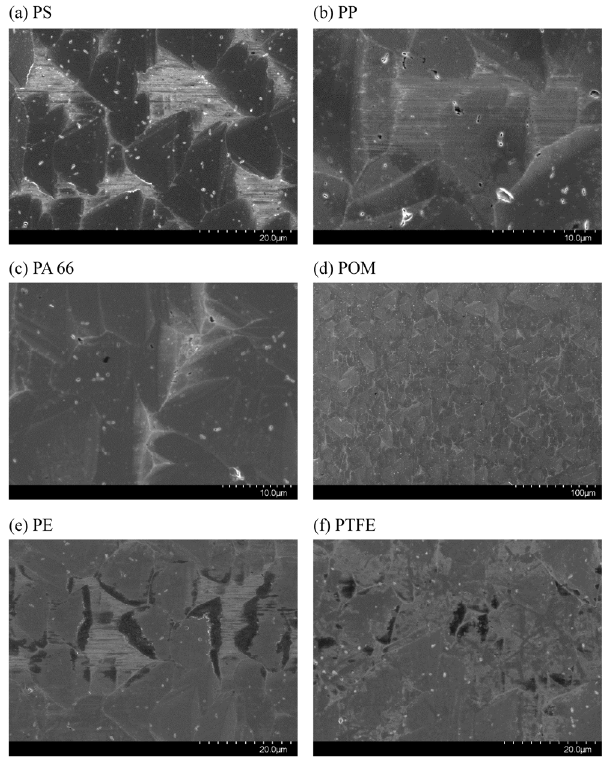
Fig. 12 Morphology of the rough silicon surface after friction with different polymer spheres with vertical contact. (a) PS; (b) PP; (c) PA 66; (d) POM; (e) PE; and (f) PTFE.